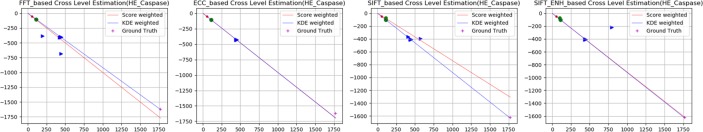
An example of hierarchical linear regression registration.Registration results of each image level were displayed into dots with different shapes for a single WSI. Weighted with similarity score and KDE confidence value, linear regression results are shown in straight lines with different colors. Ground truth is shown in a blue cross.